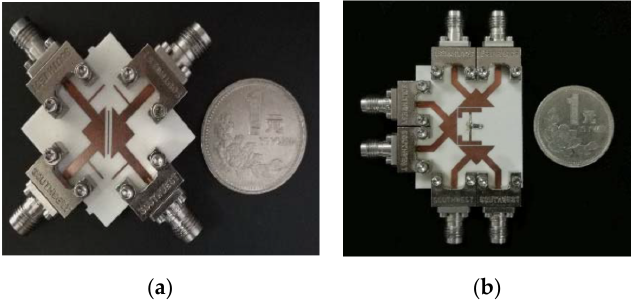
Figure 3. The proposed differential planar structure [45]: ( a ) Balanced BPF; ( b ) Balanced-to-balanced filtering power divider.